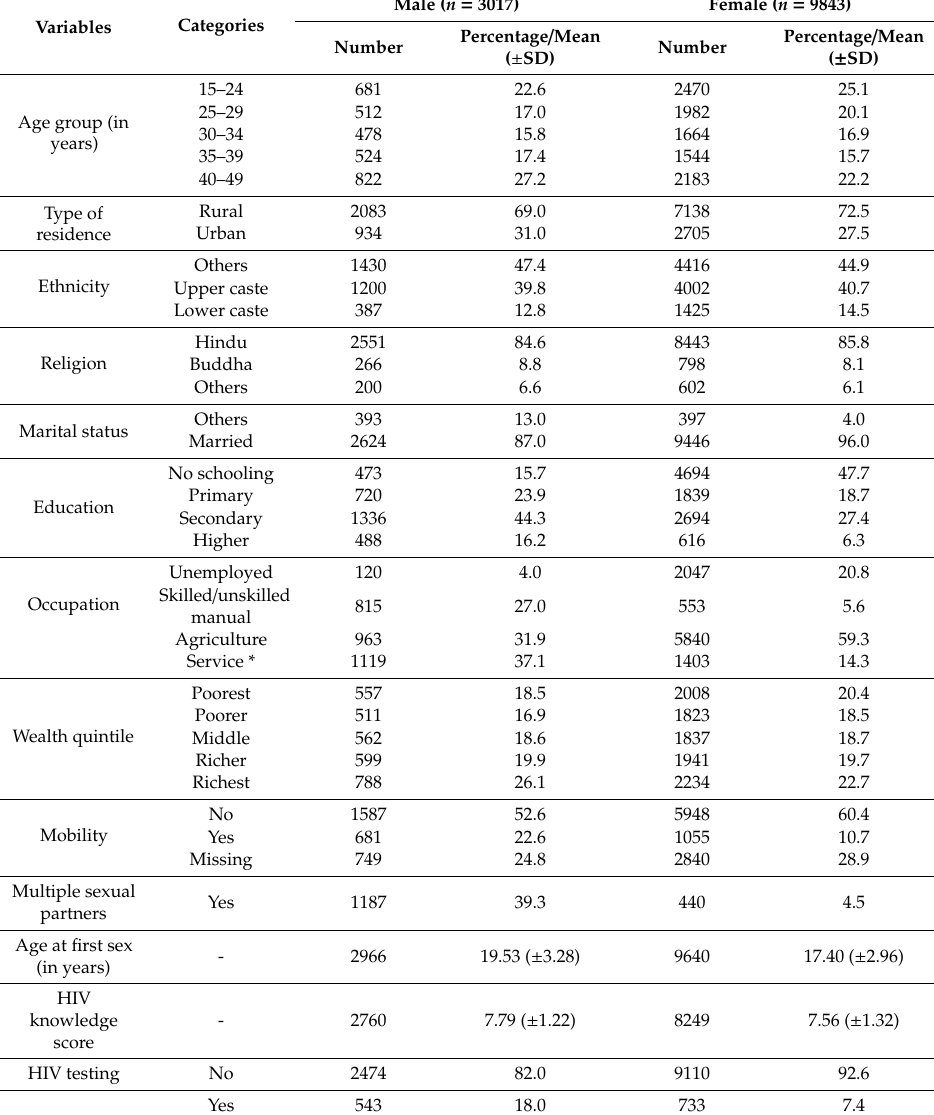
Table 2. Sociodemographic Characteristics of the Study Population ( N =